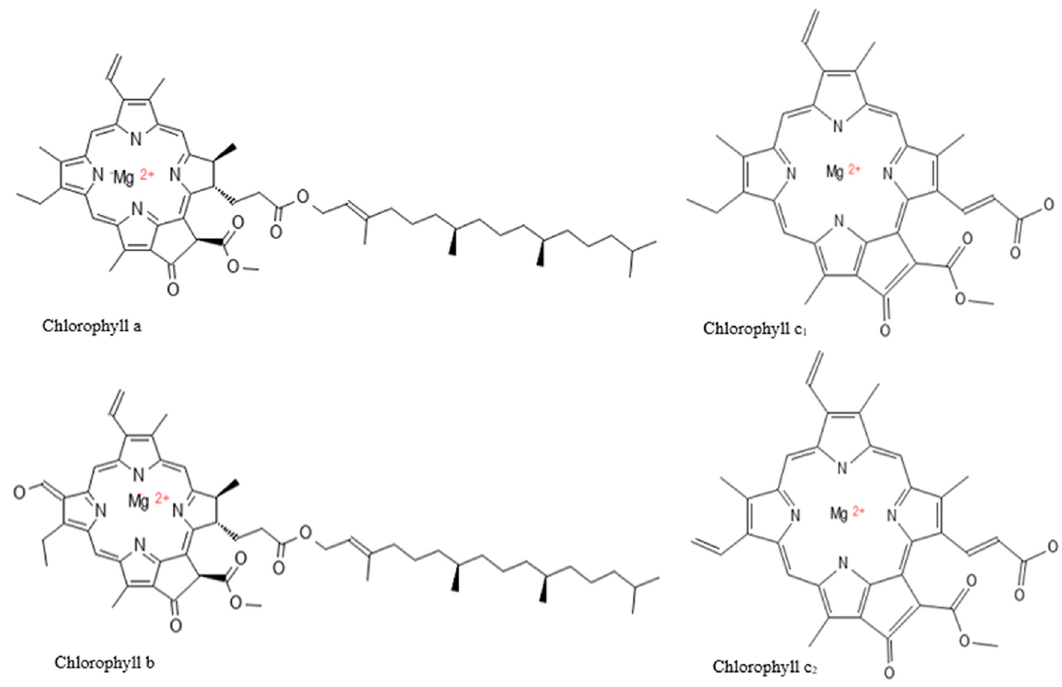
Figure 1: Chemical structure of Chl a , b , c 1 , and c 2